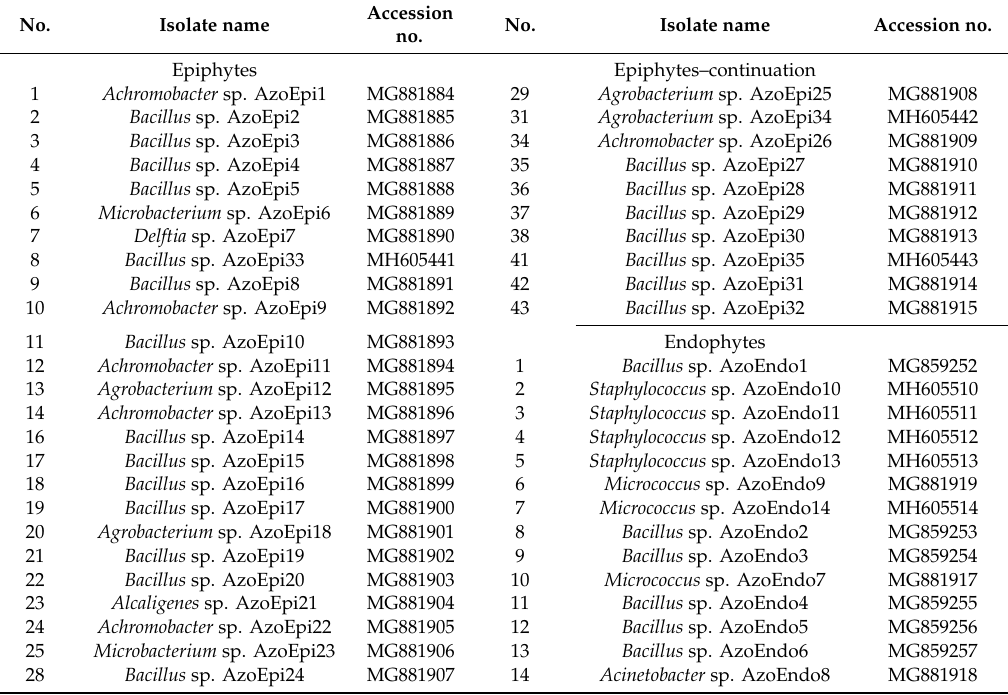
Table 3. List of identified microorganisms (accession numbers from GenBank, NCBI). Column ‘No.’ represents the number of isolate corresponding to these in Table 2. Note some missing numbers due to unsuccessful